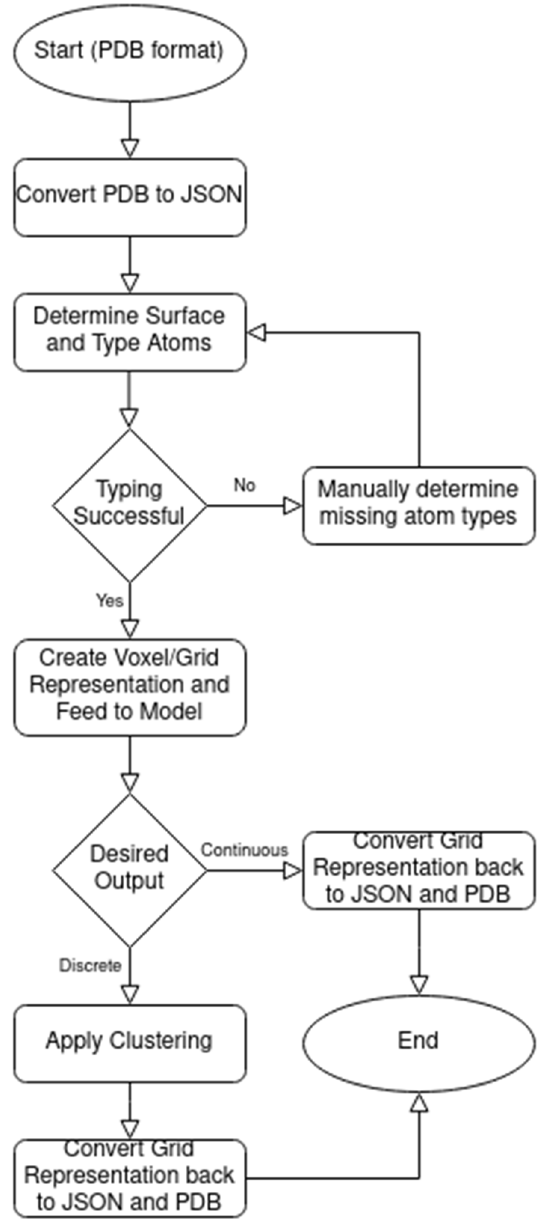
Figure 4. Flowchart of DeepDISE.